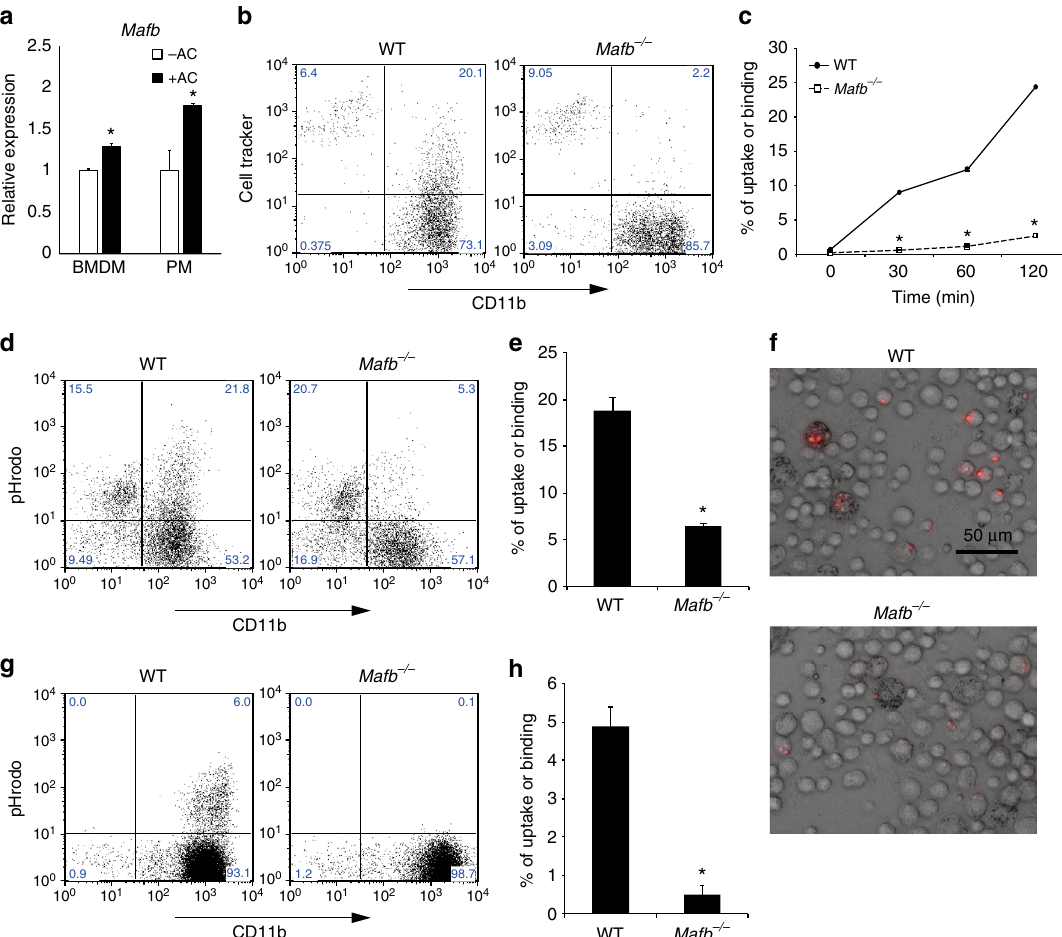
Fig. 1 Mafb -de fi cient macrophages are unable to engulf apoptotic cells. a Apoptotic cell-induced expression of Mafb in both BMDMs and PMs. Mafb mRNA was quanti fi ed by qRT-PCR; n = 4 for each group. The data were normalized to Hprt mRNA levels and are presented as the mean ± s.e.m., * p < 0.05 compared with apoptotic cells ( − AC) (Student ’ s t -test). The data are from one experiment representative of two independent experiments. b , c Jurkat T cells were induced to apoptosis and labeled with CellTracker. Apoptotic cells were incubated with WT and Mafb − / − macrophages. CD11b and CellTracker double-positive populations represent macrophages that bind and/or engulf apoptotic cells. c The percentage of binding or uptake of apoptotic cells was increased in a time-dependent manner in WT but not Mafb − / − (WT, n = 5; Mafb − / − , n = 6). d , e Apoptotic thymocytes were stained with pHrodo and incubated with fetal liver-derived macrophages for 120 min. e The percentage of cells that were taken up was signi fi cantly reduced in Mafb − / − macrophages ( n = 5 for each group). g , h , f Peritoneal exudate cells (PECs) were analyzed by FACS after apoptotic thymocytes treated with pHrodo were injected into the mice, which were injected with thioglycolate 3 days before. h The percentage of apoptotic cell uptake was signi fi cantly reduced in Mafb − / − macrophages (WT, n = 4; Mafb − / − , n = 5). f Microscopic analysis showed that pHrodo fl uorescence was observed in the PECs of WT, but not Mafb − / − . c , e , h Quanti fi cation data are presented as the mean ± s.e.m. * p < 0.05 compared with WT, (Student ’ s t -test). The data are from one experiment that